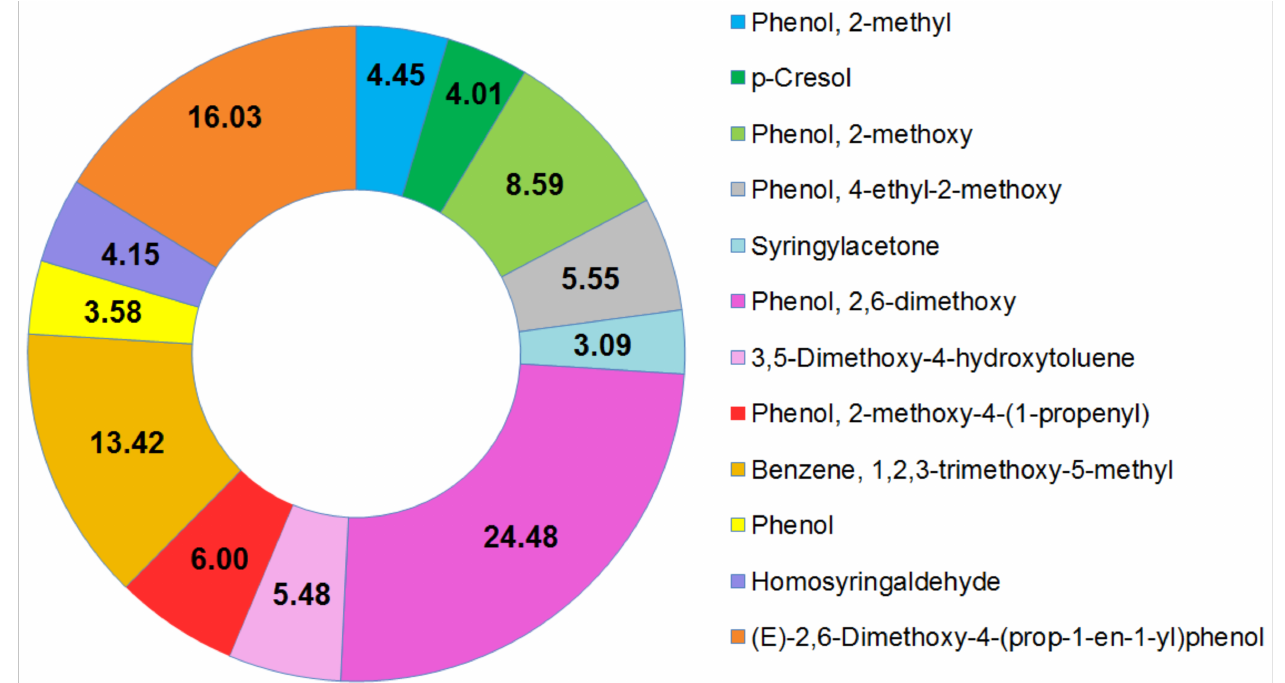
Figure 7. Chemical composition of the oil fraction of the